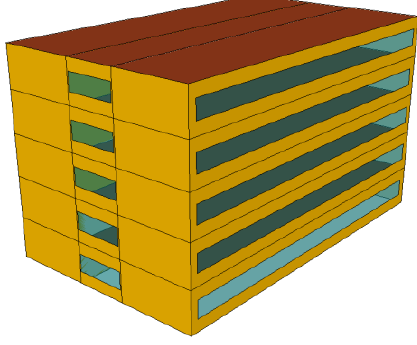
Figure 4. Hospital building (ward).